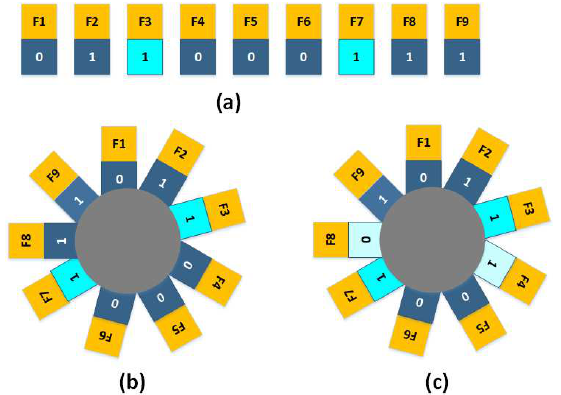
Figure 7. Mutation neighborhood search strategy ( a ) feature solution, ( b ) ring feature solution, ( c ) right neighbors